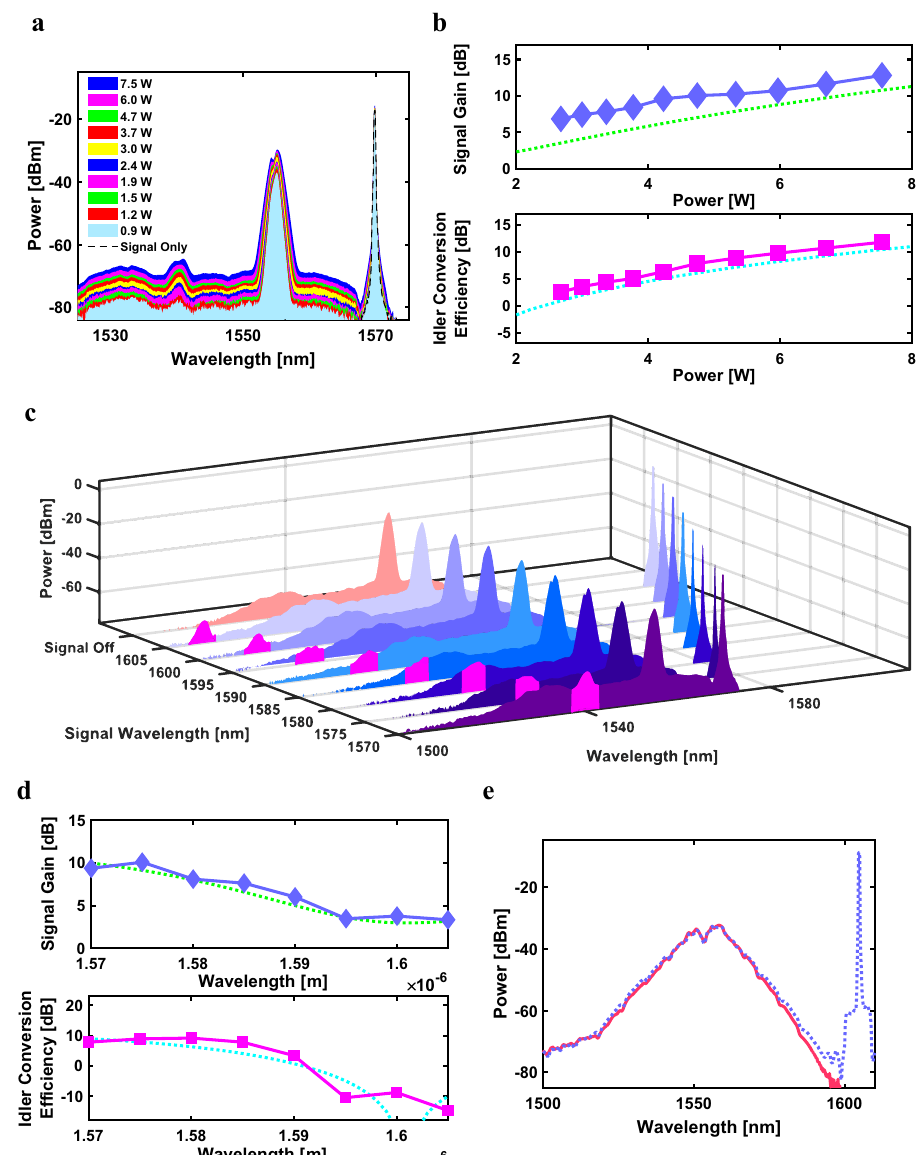
Fig. 3 | Experimentallymeasured opticalparametric wavelength conversionin the topological boundary states. a Four-wave mixing spectrum for 5ps pump pulses and as a function of pump peak power. The different spectra represent increasing pumppeakpowers from 0.9 to 7.5W. Signalsidebandscharacteristic of parametric gain are shown to develop when the pump is on. b Measured (blue diamonds) and calculated (green dashed line) signal gain as a function of peak power calculated using the coupled equations. Measured (fuchsia squares) and calculated(cyandashedline)idlerconversionef fi ciencyasafunctionofpumppeak power. c Four-wave mixing spectra as a function of signal wavelength. The signal